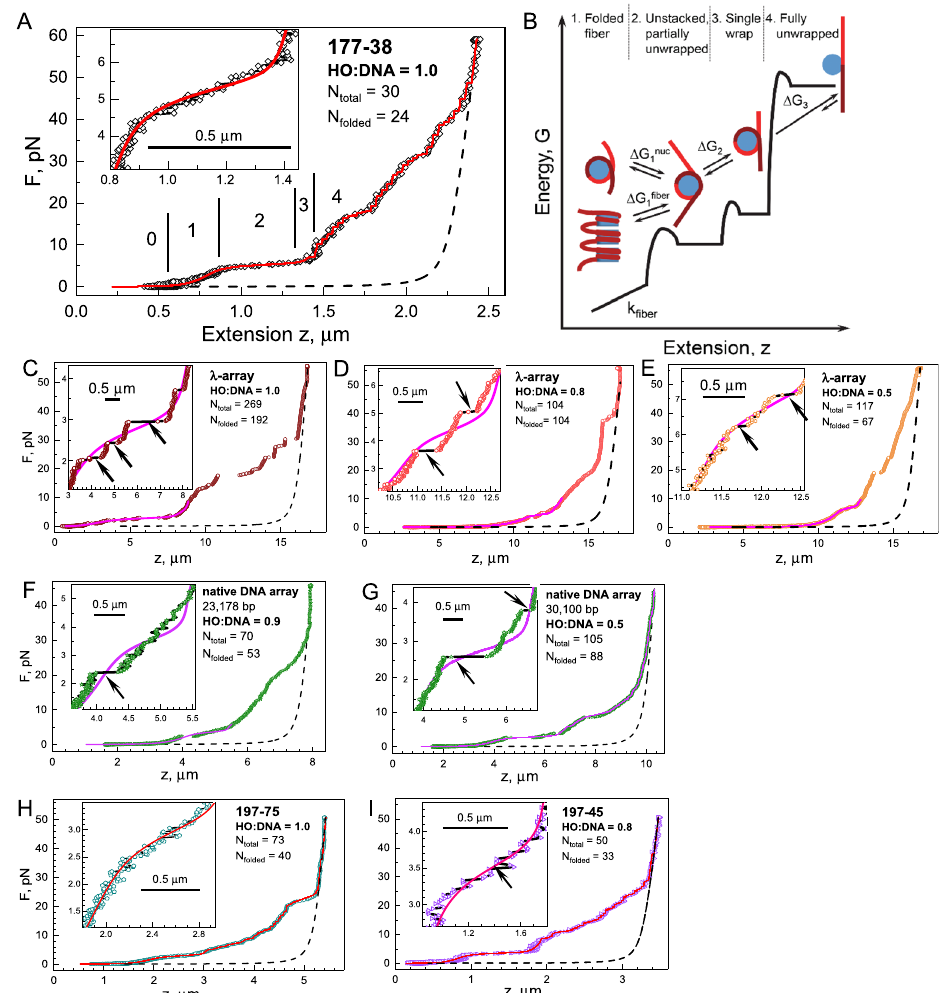
Figure 2. Single-molecule force spectroscopy reveals not only unstacking and unwrapping of nucleosomes in chromatin fibers but also large rupture events indicative of trans-interactions between remote parts of the chromatin fiber. ( A ). Example of an experimental stretching curve. Points are recorded data; the red line shows the model fitting. Different stages of the fiber stretching are indicated with numbers referring to the respective transition shown in ( B ). “0” indicates the extension of the bare DNA. ( B ). Statistical mechanics model for the single-molecule nucleosome array stretching. Free energy—extension scheme illustrating different stages of the nucleosome array extension under the influence of the stretching force. Deformation of the fiber includes (1) extension of the folded array; (2) transition of the array from a fiber to a bead-on-a-string chain accompanied by nucleosome unstacking and partial DNA unwinding; (3) deformation of the nucleosomes with further DNA unpeeling and possible dissociation of the histone dimer(s); (4) largely irreversible one-step rupture of the last turn of the DNA wrapped on the histone core. A detailed description of the model is given in the Material and Methods section. ( C – E ) λ-arrays form heterogeneous nucleosome clusters. Sample curves of the λ-array stretching recorded for the HO:DNA ratios 1.0 ( C ), 0.8 ( D ), and 0.5 ( E ). ( F , G ) native DNA array at HO:DNA ratio 0.9 ( F ) and ratio 0.5 ( G ). (H , I) Stretching curves of the arrays reconstituted on the ‘601’ positioning DNA template: ( H ) 197-75 array; ( I ) 197-45 array . Inserts show low-force regions corresponding to the stretching of the compacted arrays. Arrows indicate cluster–cluster ruptures. In each panel, the horizontal bar corresponds to 0.5 μm. Points connected by the lines are experimential data, smooth curves are statistical mechanics model fitting, and arrows indicate cluster–cluster ruptures. Dashed lines show the extension of the bare DNA calculated using the DNA contour length and the WLC model. OriginPro software 75 (http:// www. origi nlab. com) was used to create the graphs in ( A ) and ( C – I ). Microsoft PowerPoint 2016 (http:// www. micro soft. com) was used to draw the image in ( B